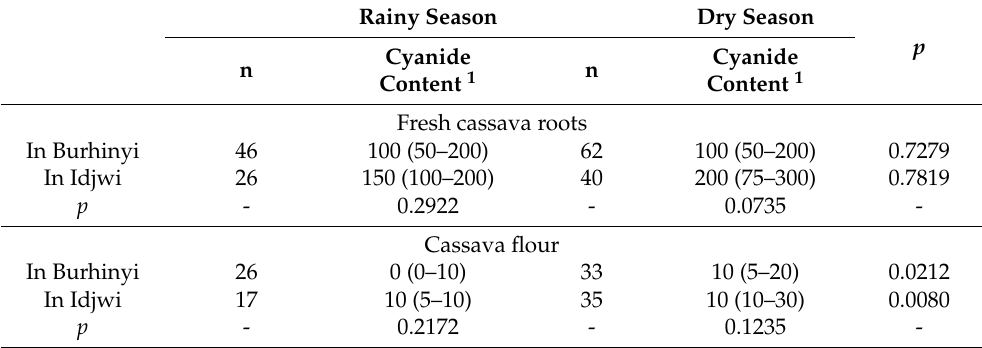
Table 4. Content in cyanide of raw cassava roots and cassava flour by seasons and